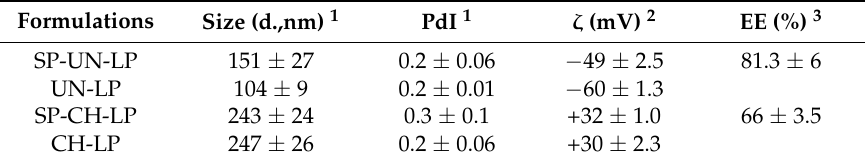
Table 1. Physicochemical properties of coated (CH-LP) and uncoated liposomes (UN-LP) and the corresponding SP-loaded liposomes (SP-CH-LP and SP-UN-LP) ( n =